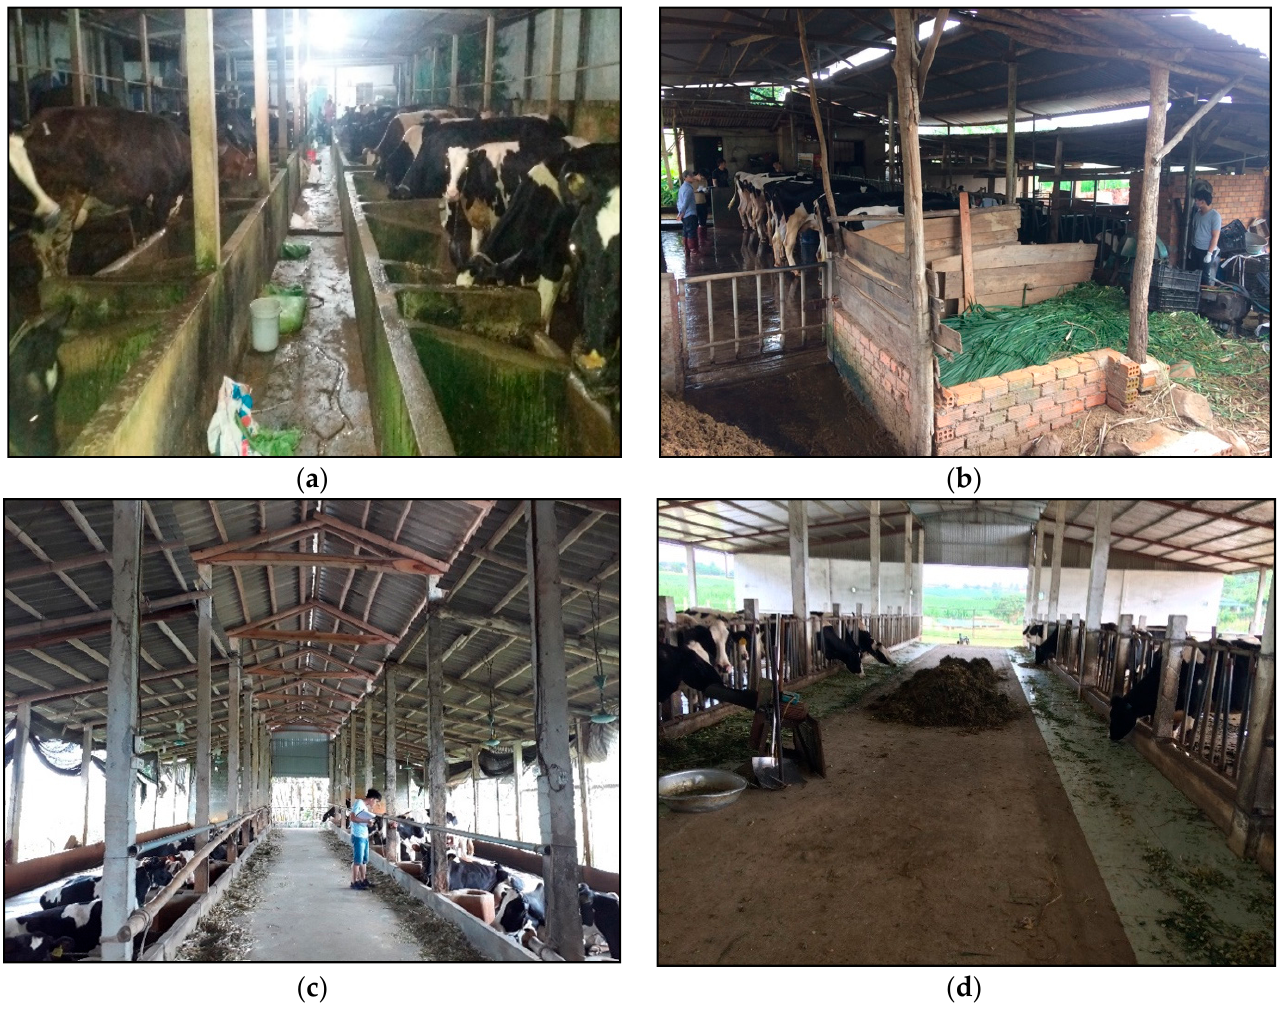
Figure 1. Typical interiors of smallholder dairy farms in each study region. ( a ) South lowland, ( b ) South highland, ( c ) North lowland and ( d ) North highland.